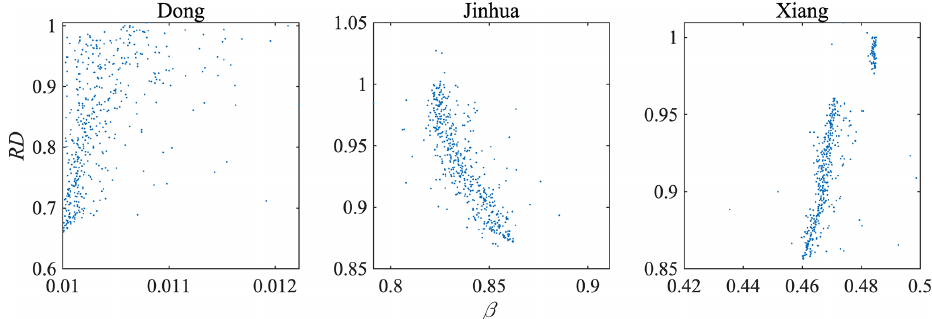
Figure 6. Relationship between β and RD in the three cases.